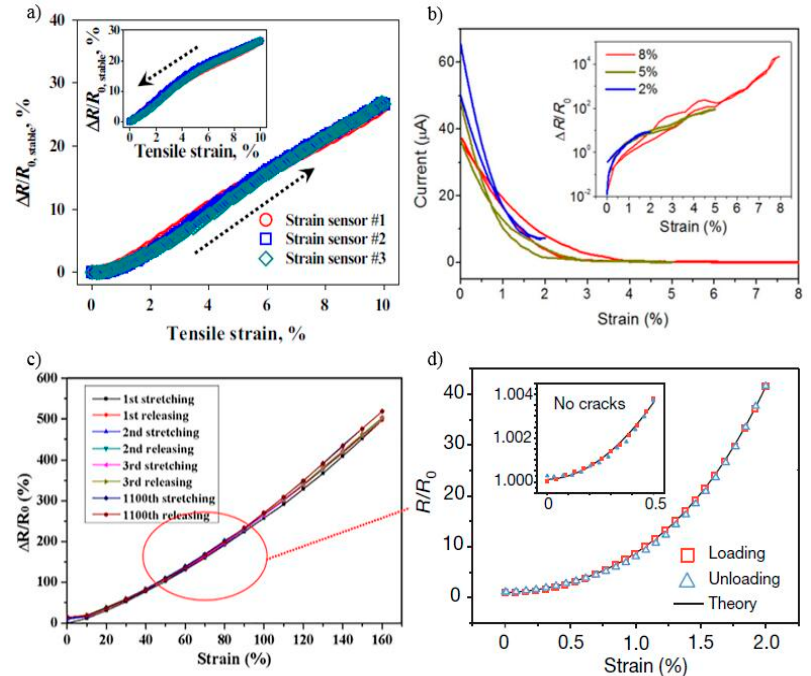
Figure 2. ( a ) Resistance change ratios obtained from three identical conductive PDMS strain sensors with a maximum strain of 10% after stabilization. Reprinted with permission from [75], Copyright Elsevier, 2014; ( b ) The graphene-on-polymer strain sensors show high gauge factors under electrical resistance of graphene woven fabrics, which increases exponentially with tensile strain. Reprinted with permission from [73], Copyright Springer Nature, 2012); ( c ) Strain sensing capability of stretchable EGaIn/PDMS composite strain sensor with cycles of stretching/releasing. Reprinted with permission from with [67], Copyright AIP Publishing, 2016; ( d ) Resistance of sensors based on nanoscale crack junctions at low loading-unloading rate compared with the theoretical fit. Reprinted with permission from [78], Copyright Springer Nature, 2014.